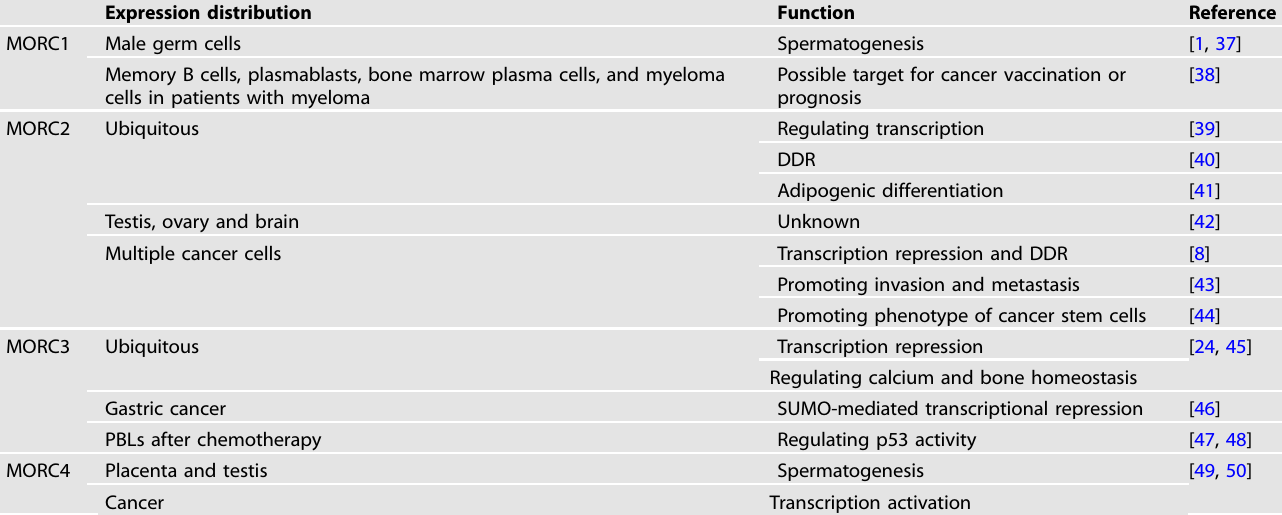
Table 2. Expression distribution and functions of MORC